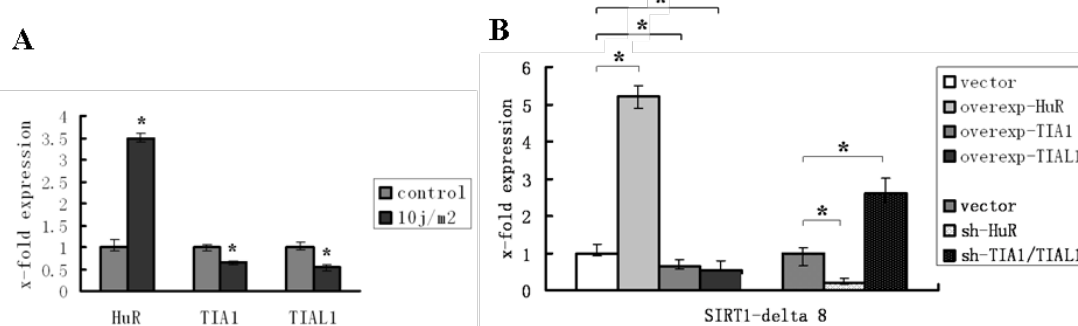
( C ) The levels of SIRT1-FL mRNA no significant change. * p < 0.05 compared to